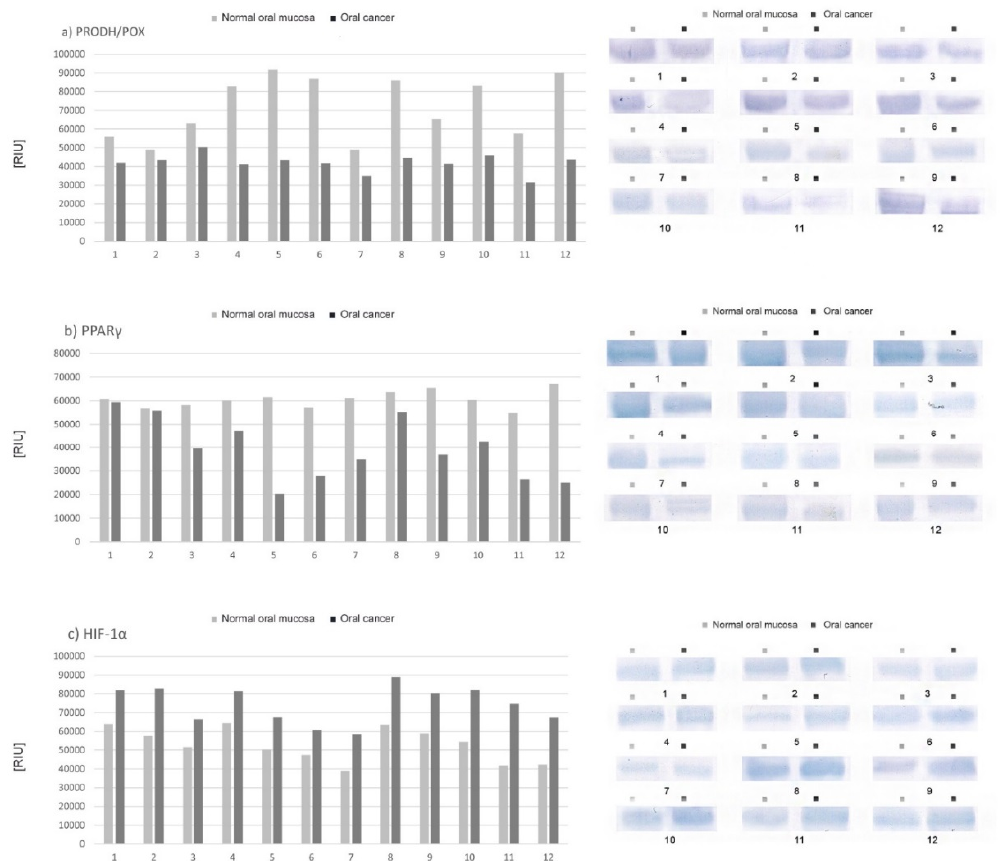
Figure 2. Expression of selected proteins involved in proline metabolism and important in the process apoptosis: ( a ) proline dehydrogenase / oxidase (PRODH / POX), ( b ) PPAR- γ , ( c ) HIF-1 α ; the comparison of apoptosis: ( a ) proline dehydrogenase/oxidase (PRODH/POX), ( b ) PPAR-γ, ( c ) HIF-1α; the of oral cancer tissue with normal oral mucosa of individual comparison of oral cancer tissue with normal oral mucosa of individual patients.